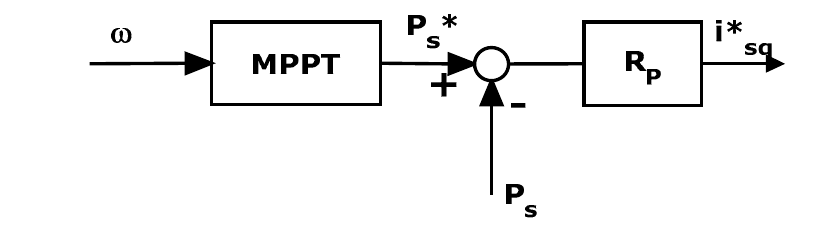
Figure 6. Power controller block diagram (Type II). Figure 5. Power controller block diagram (Type II).